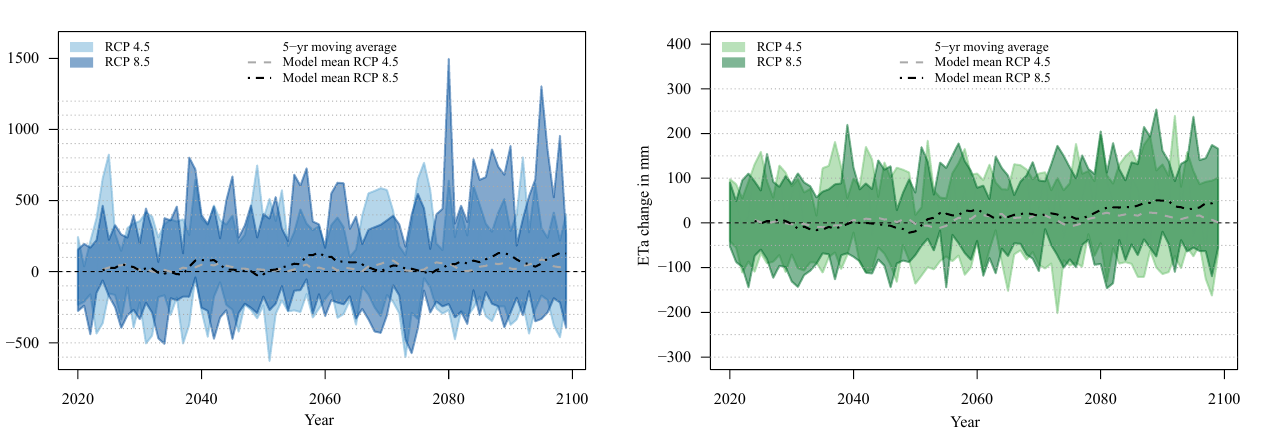
Figure 7. Anomalies of annual precipitation amounts relative to the reference period (1970–1999). Range of selected model ensemble.